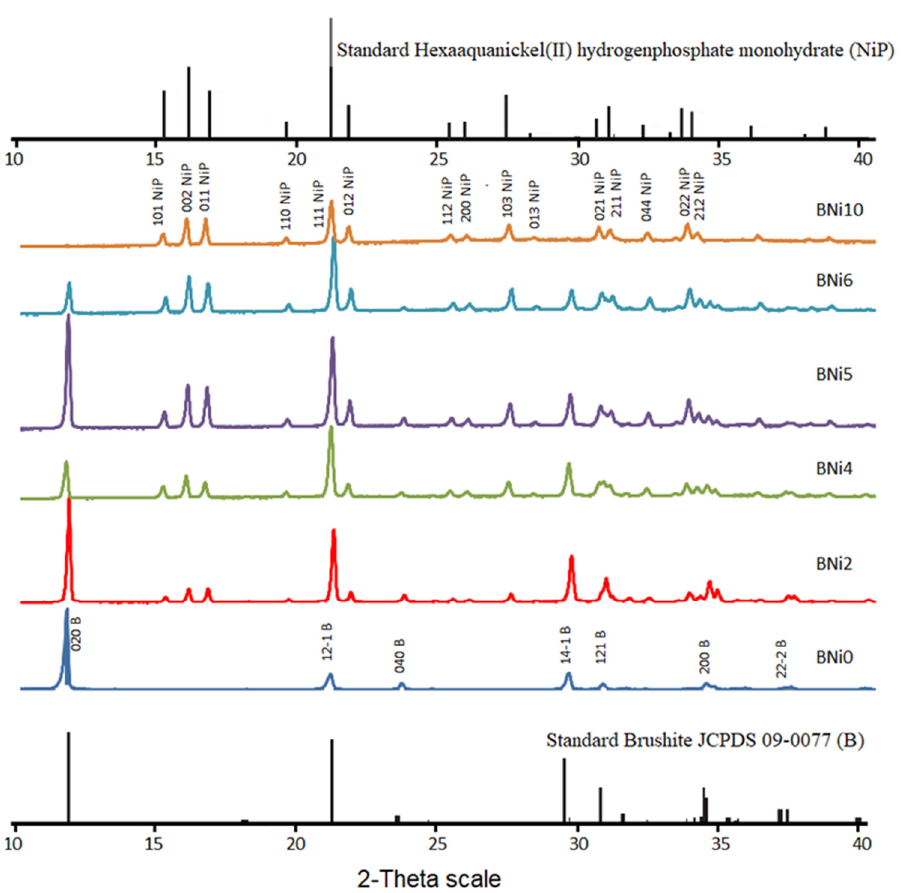
Figure 1 . XRD patterns of the CaxNi 1-x HPO 4 ·nH2O compounds synthesized under the conditions Figure 1. XRD patterns of the Ca x Ni 1 − x HPO 4 · nH 2 O compounds synthesized under the conditions provided in Table 1. provided in Table